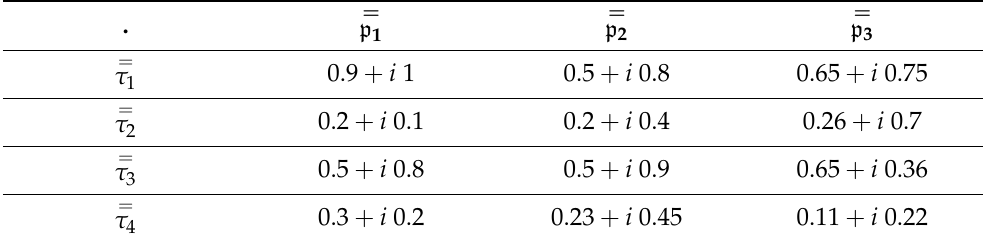
Table 12. The tabular description PTG of scenario 2.